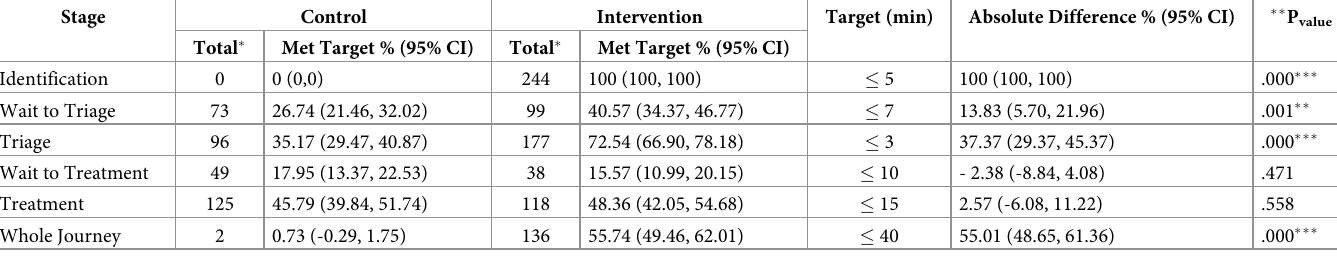
Table 6. Performance targets–comparison.